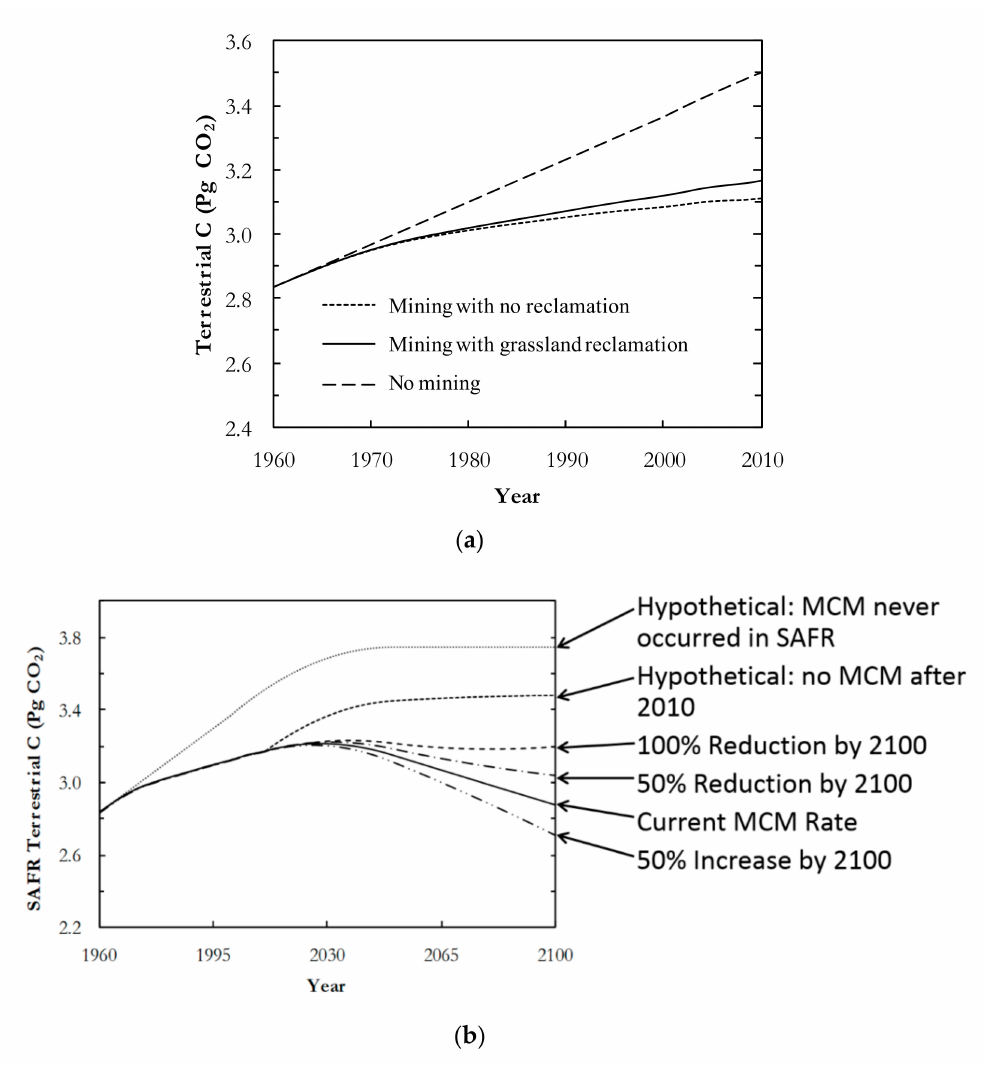
Figure 10. ( a ) Historical forest carbon stocks (soil and vegetation) for the Southern Appalachian Forest Region (SAFR) for three alternative scenarios: (1) mining with no reclamation (small dashes); (2) mining with grassland reclamation (solid line); (3) no mining (large dashes). ( b ) Terrestrial carbon projections in the Southern Appalachian forests with sequestration from forest regrowth occurring on all Southern Appalachian forests lands and grassland reclamation on MCM lands. Hypothetical scenarios are shown to reference the carbon sequestration potential from secondary forest growth. Alternative mining rate scenarios are the annual area of deforestation at the current annual rate (0% reduction) and linear changes in annual rates by the year 2100 (100% reduction, 50% reduction, 50%